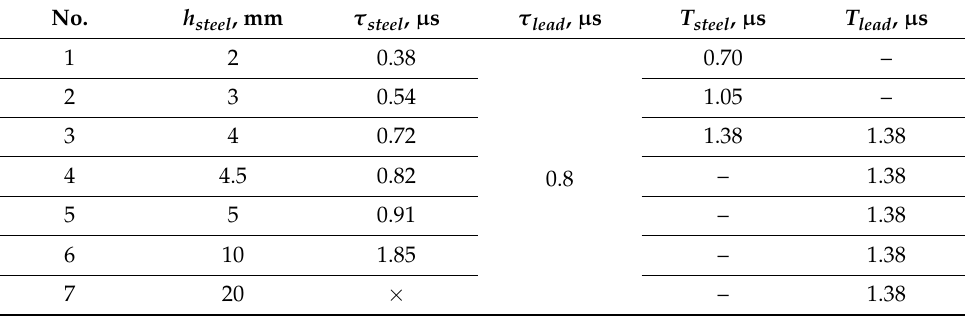
Figure 3. Predicted velocity (black curve) and acceleration (orange curve) of the contact boundary between metal plates; h steel = 3 mm, h lead = 2 mm; simulation using the HLLC method. Table 1. Times of arrival of an SW to the free boundary of a plate ( τ ) and arrival of an RW to the interfacial boundary between the plates ( T ) for the steel and lead plates; h lead = 2 mm; simulations using the HLL